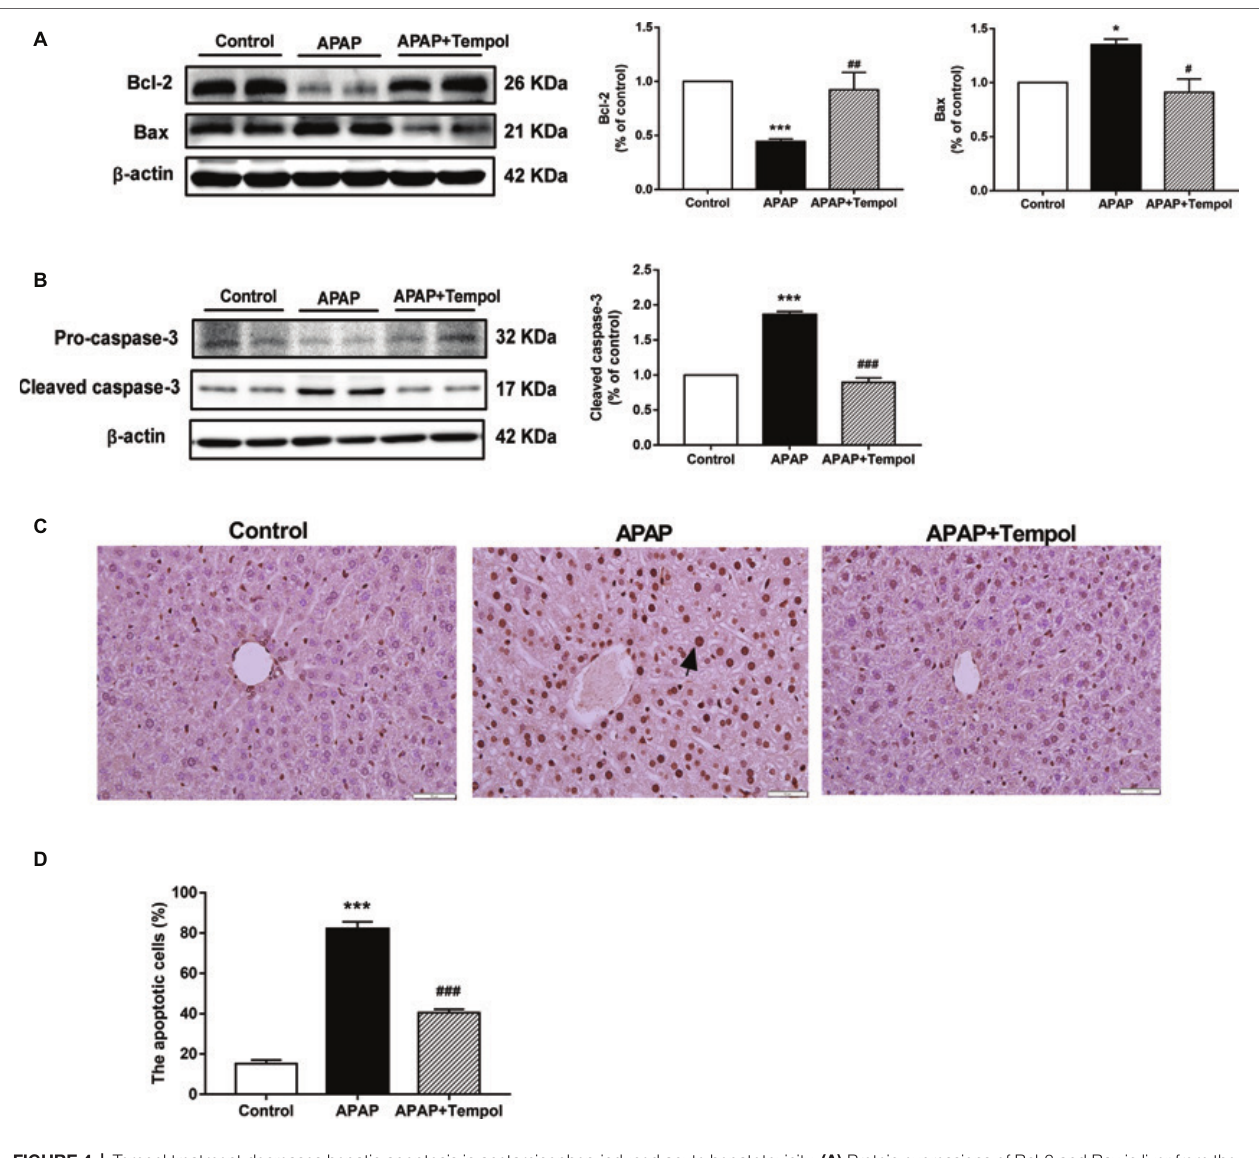
FIGURE 4 | Tempol treatment decreases hepatic apoptosis in acetaminophen-induced acute hepatotoxicity. (A) Protein expressions of Bcl-2 and Bax in liver from the control mice (control), vehicle-treated hepatotoxicity mice (APAP), and tempol-treated hepatotoxicity mice (APAP + tempol). (B) Protein expressions of pro-caspase-3 and cleaved caspase-3 in liver from three groups. (C) Tunel-staining of hepatic tissues from three groups. The black arrow indicates typical apoptotic cells. Scale bar = 50 μm. (D) Percentage of TUNEL-positive cells evaluated by image analyzer. Data are mean ± SEM. * p < 0.05 vs. control, # p < 0.05 vs.